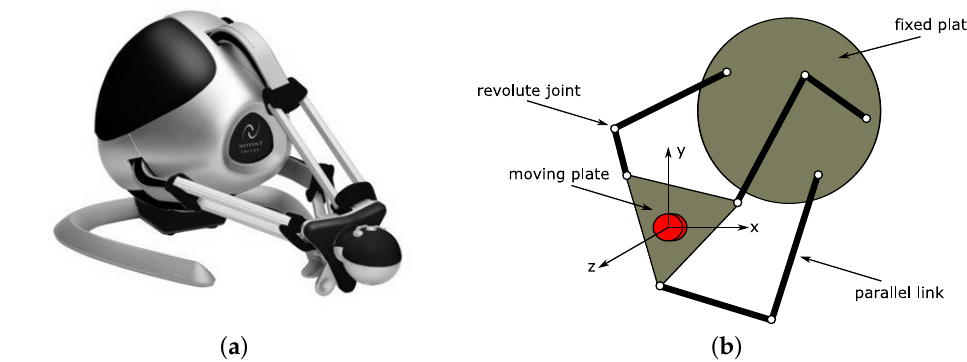
Figure 2. The Novint Falcon haptic device: ( a ) apparatus and ( b ) kinematic